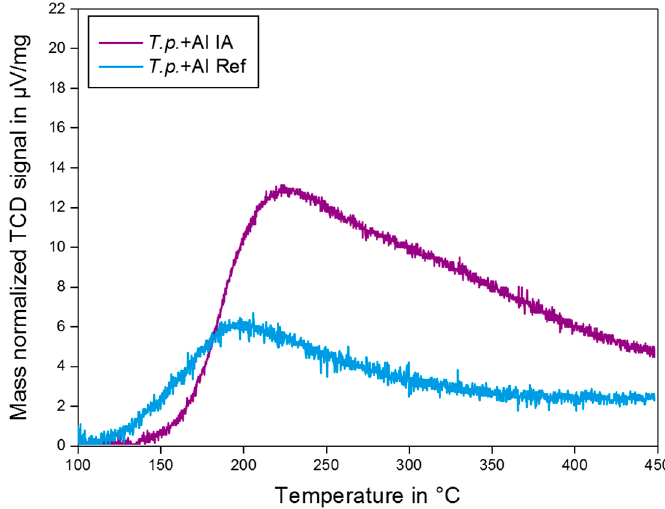
Figure 5. TPD profiles of biosilica enriched with aluminum, calcined only (blue) and with additional ion exchange (violet).